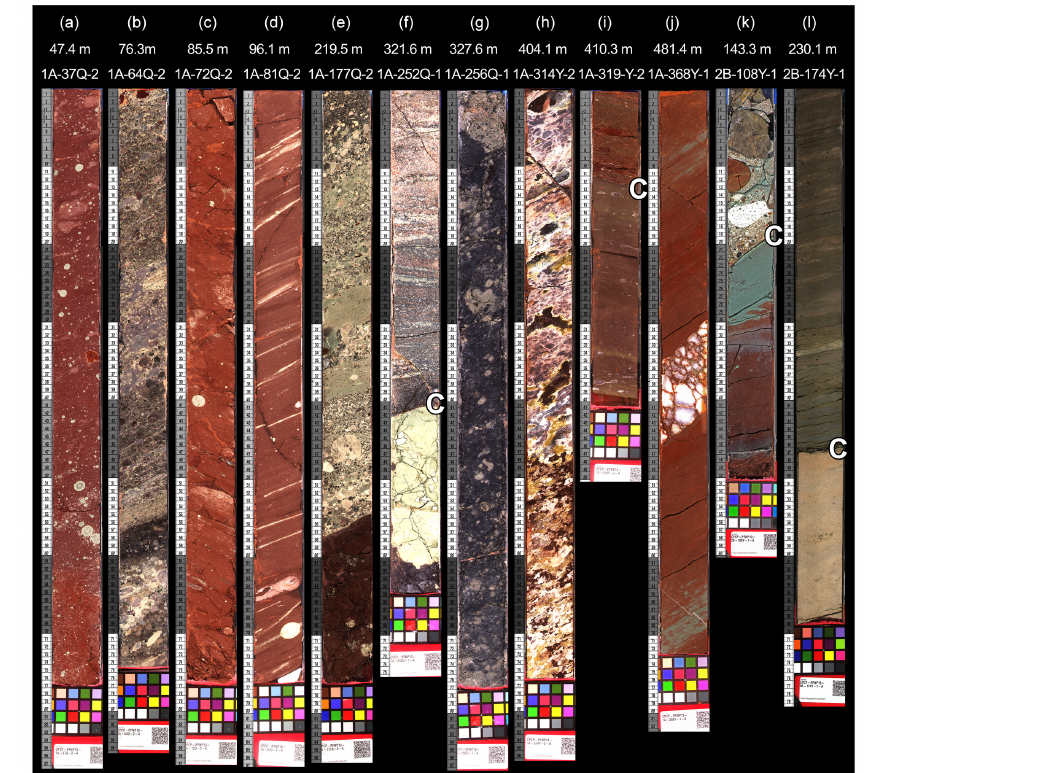
Figure 9. Representative facies in core segments from cores CPCP-PFNP-13-1A (a–j) and CPCP-PFNP-13-2B (k–l) with bedding dipping down towards left except as noted (see Fig. 5): (a) pedogenic mudstone of lower Owl Rock Member of the Chinle Formation in which bedding is obscure but indicated by long axes of elliptical spots (“reduction spots or haloes”); (b) lower Black Forest Bed of the Petrified Forest Member of the Chinle Formation with abundant intraformational carbonate clasts and volcaniclastic material; (c) pedogenic mudstone of the Petrified Forest Member of the Chinle Formation with long axis of elliptical spots inclined downward to the right indicating a misoriented core segment; (d) pedogenic ripple-bedded fine sandstone and siltstone of the Petrified Forest Member of the Chinle Formation with long axes of elliptical spots clearly aligned with bedding; (e) sandstone and conglomerate overlying pedogenic mudstone within the upper Sonsela Member of the Chinle Formation; (f) Contact C between coarse sandstone of the overlying Sonsela Member of the Chinle Formation and the underlying Blue Mesa Member of the Chinle Formation; (g) pedogenic mudstone of the Blue Mesa Member of the Chinle Formation; (h) four-color mottled pedogenic mudstone of the Mesa Redondo Member of the Chinle Formation; (i) Contact C between sandstone of the overlying Mesa Redondo Member of the Chinle Formation and sandstone and siltstone of the underlying Holbrook Member of the Moenkopi Formation (core segment appears misoriented); (j) chicken-wire gypsum bed in siltstone of the Moqui Member of the Moenkopi Formation; (k) Contact C between cobble conglomerate of the overlying Shinarump Member of the Chinle Formation and sandstone and siltstone of the underlying Holbrook Member of the Moenkopi Formation; (l) Contact C between sandstone of the overlying Wupatki Member of the Moenkopi Formation and sandstone of the underlying Coconino Sandstone of Early Permian